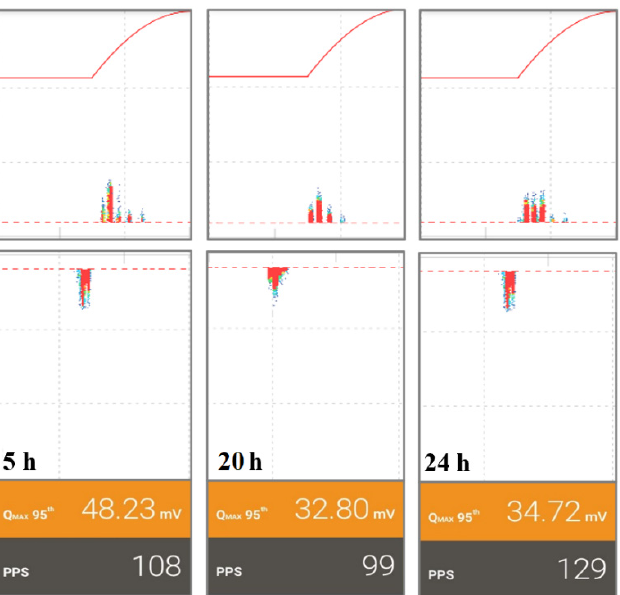
Figure 9. DCP voltage PRPD patterns with δ = 0.6, acquired after 5, 20 and 24 h of applied voltage. To save space compared to Figure 8, the PRPD patterns positioned in the upper part are obtained during the DCP rising time, while those in the bottom part refer to the DCP falling time.